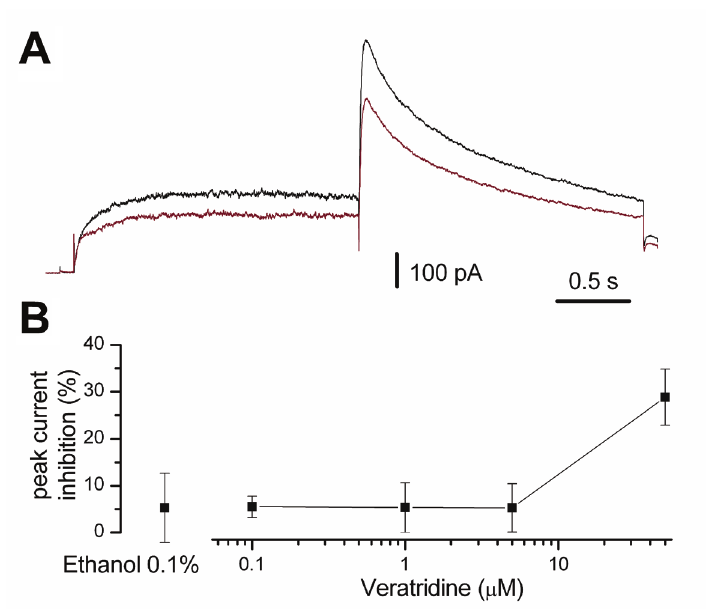
Figure 5. Effects of veratridine on hERG channels. A . Current traces in control conditions (upper) and during application of veratridine 50 μM (lower trace). B . Percentages of peak hERG current inhibition by different concentrations of veratridine and control ethanol 0.1% vehicle. Error bars represent SD. Number of experiments: control ( n = 6), veratridine 0.1 μM ( n = 10), 1 μM ( n = 5), 5 μM ( n = 7), 50 μM ( n =